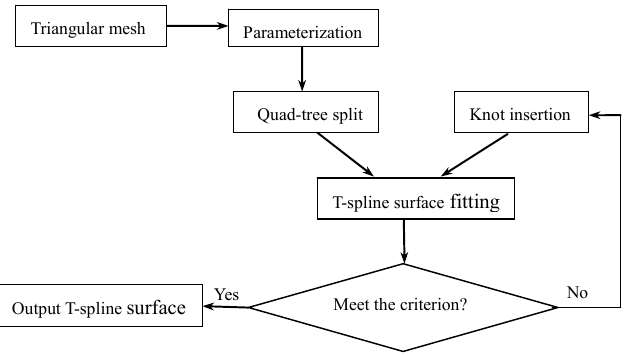
Figure 3. T-spline surface fitting step.